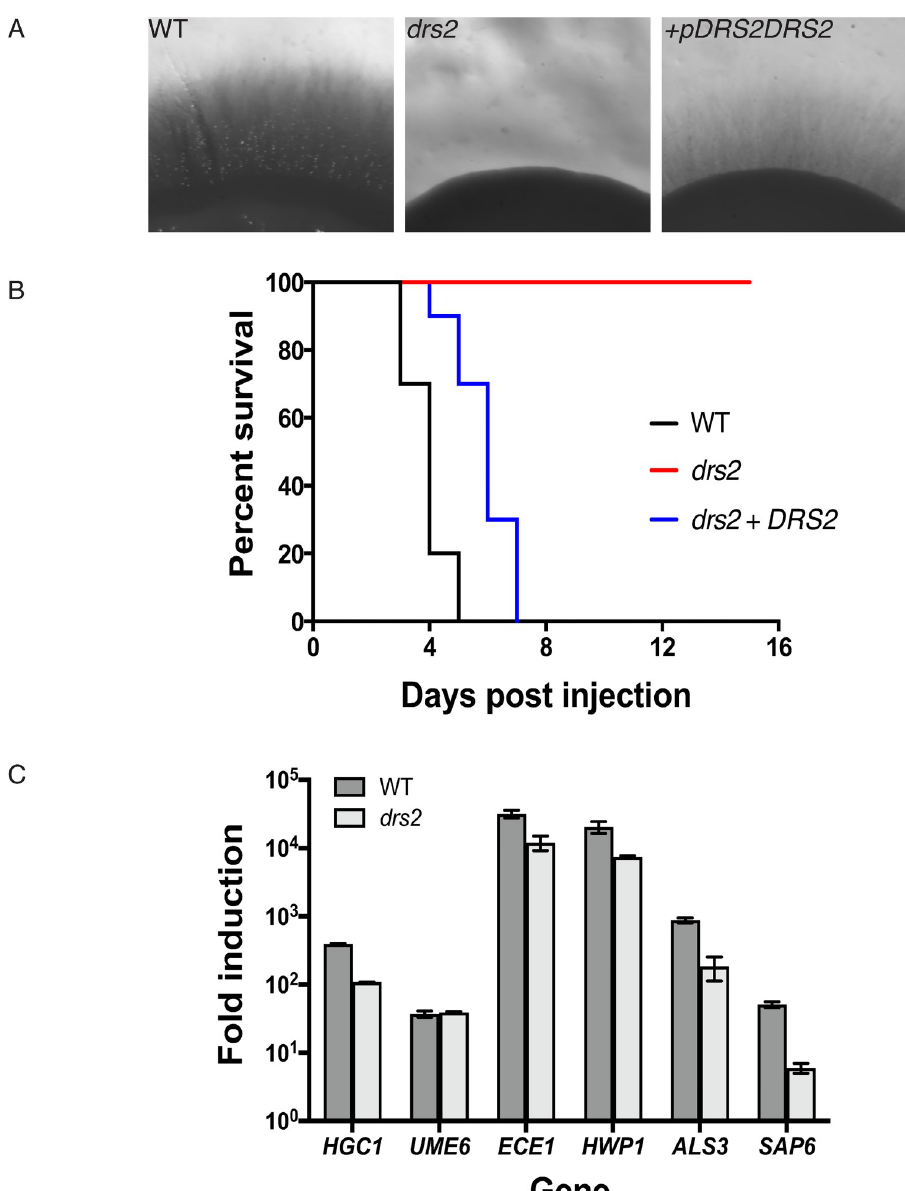
Fig 3. Drs2 is critical for virulence in a mouse model of systemic candidiasis. A) Reintroduction of DRS2 complements the invasive growth defect of the drs2 mutant. The indicated strains WT (PY4861), drs2/drs2 ( drs2 , PY3375), and drs2/drs2 + pDRS2DRS2 ( drs2 + DRS2 , PY5042), were grown as in Fig 1A and 1B) The drs2 mutant has attenuated virulence in a mouse model of hematogenously disseminated candidiasis. Balb/C mice ( n = 10) were injected with an inoculum (5 x 10 5 cells) of the indicated strains and the survival was assessed. C) Hyphal specific gene are induced in drs2 cells upon serum exposure. mRNA and cDNA were prepared from the indicated strains grown 120 min in the presence of serum. HGC1 , ECE1 , HWP1 , ALS3 and SAP6 transcripts were determined by qRT-PCR using primer pairs described in [89], and UME6 transcripts were determined using UME6.pTm/UME6.mTm (89 bp) primer pair. Bars indicate the mean ± SD ( n = 3 determinations). Similar results were observed in an additional biological replicate. NAD-linked Glyceraldehyde-3-phosphate dehydrogenase ( TDH3 ) transcript levels were used for